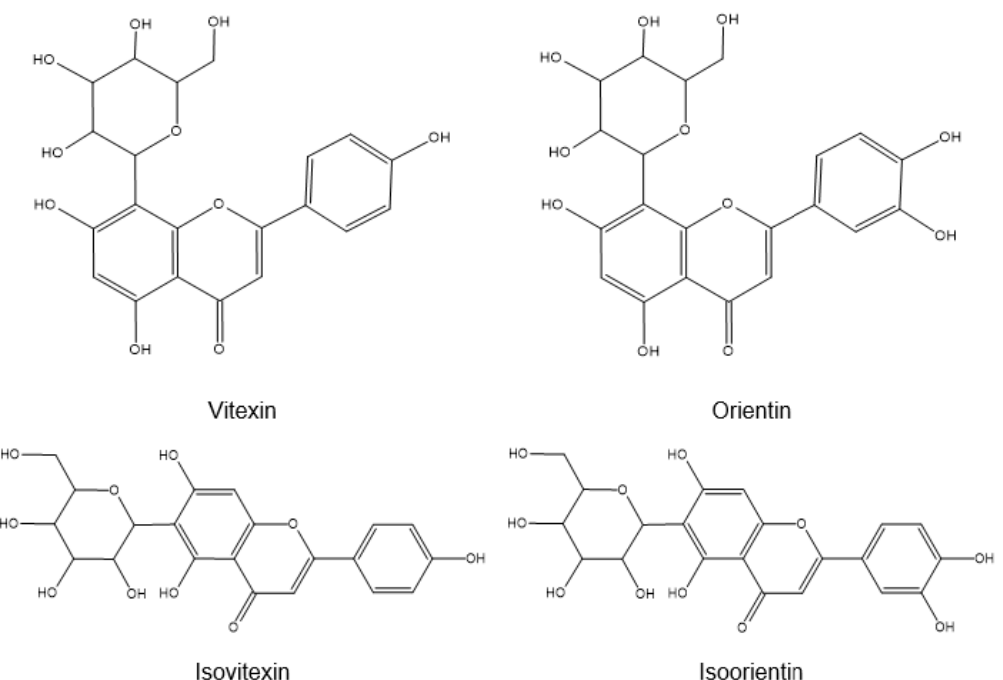
Figure 5. Structure of vitexin, isovitexin, orientin, and isoorientin.